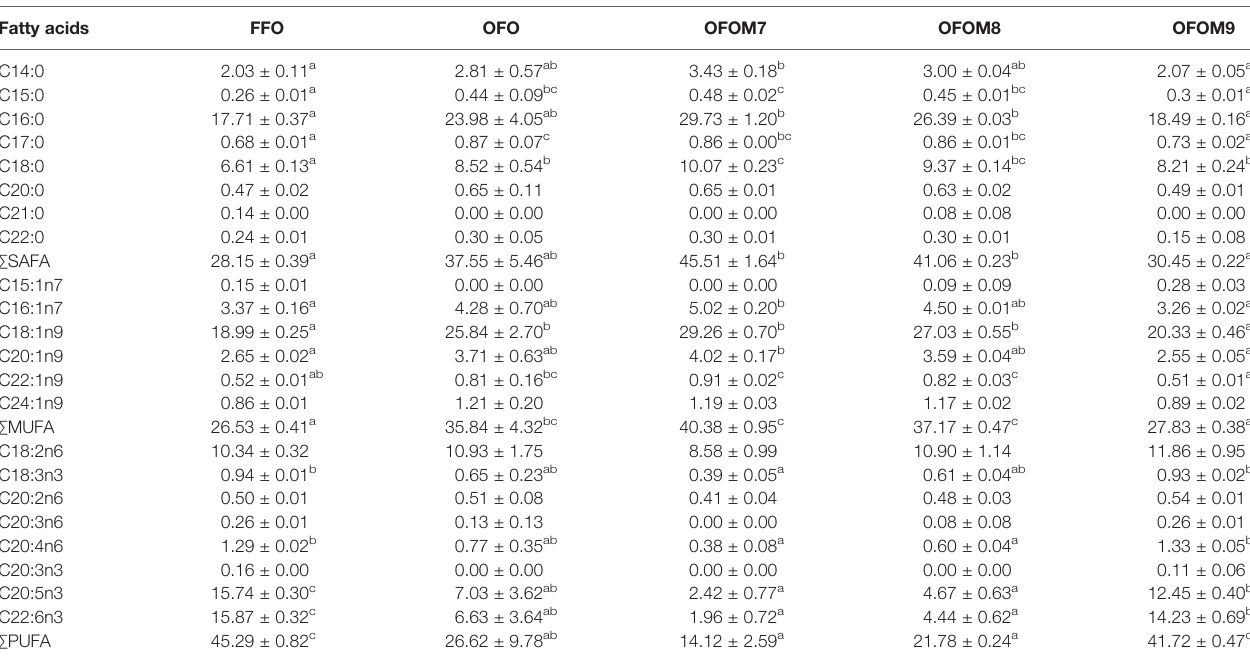
TABLE 6 | Muscle fatty acids of grouper fed different diet